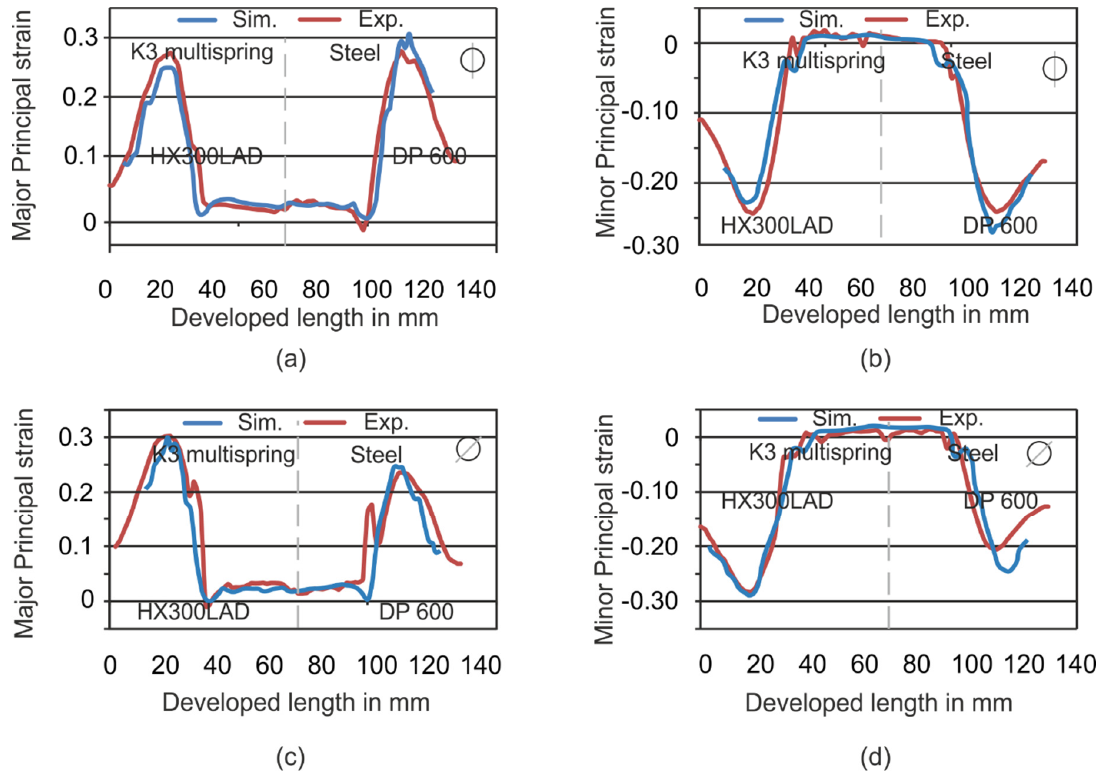
Figure 10. Comparison of major and minor strains of simulations and experiments for Setup 6.